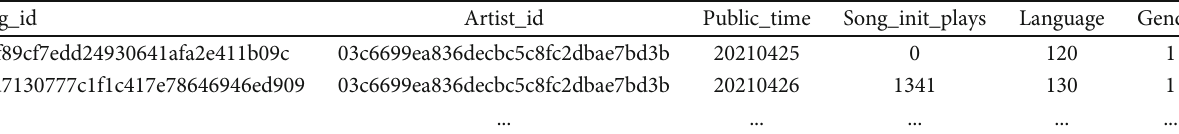
Figure 2: NNS model diagram. Table 1: Song record.